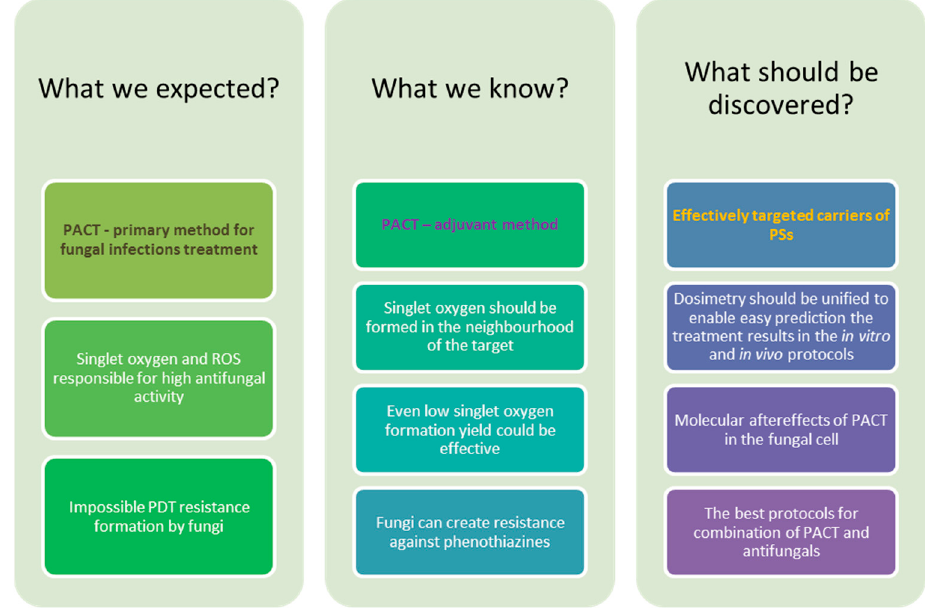
Figure 13. Conclusions in brief.